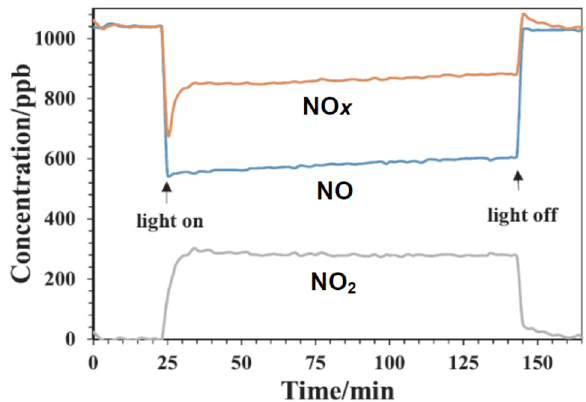
Figure 45. Concentration profiles for NO, NO 2 and NO x (NO + NO 2 ) during the photocatalytic oxidation of NO on TiO 2 hydrosol (0.1 g) photocatalysts. Reproduced with permission from Yang et al. [132]. Copyright 2018 by the authors (open access license).